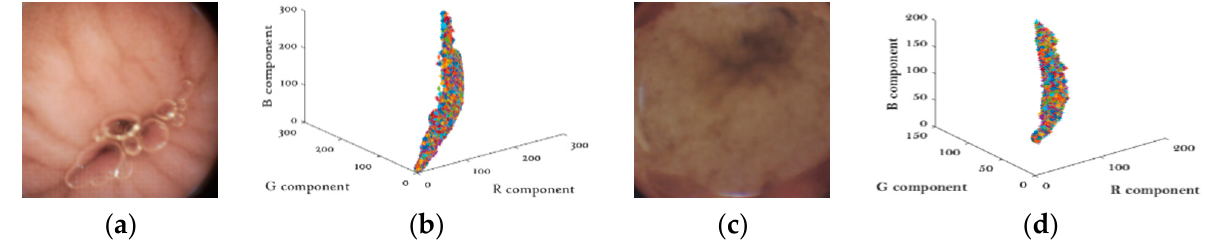
Figure 2. ( a , c ) Typical wireless capsule endoscopy (WCE) images ( b , d ) Color components distributions. Table 1. Color components correlation coefficients of WCE images.